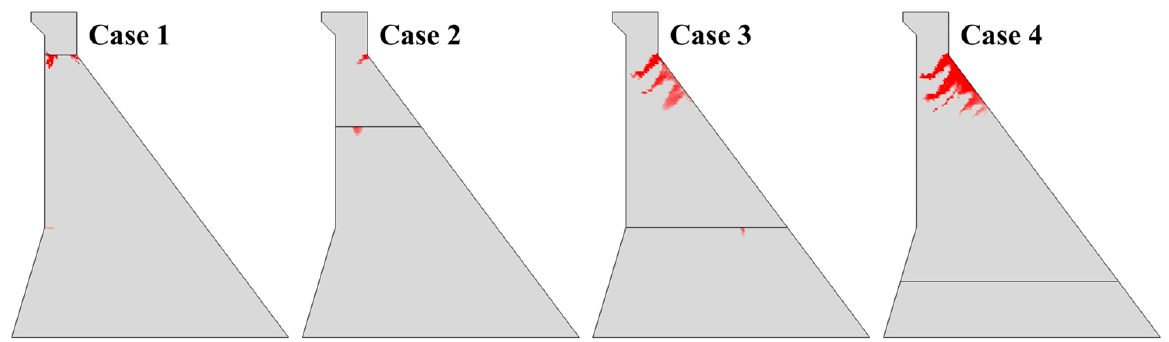
Figure 18. Damage characteristics of the dam with higher strength grade concrete in the upper part.